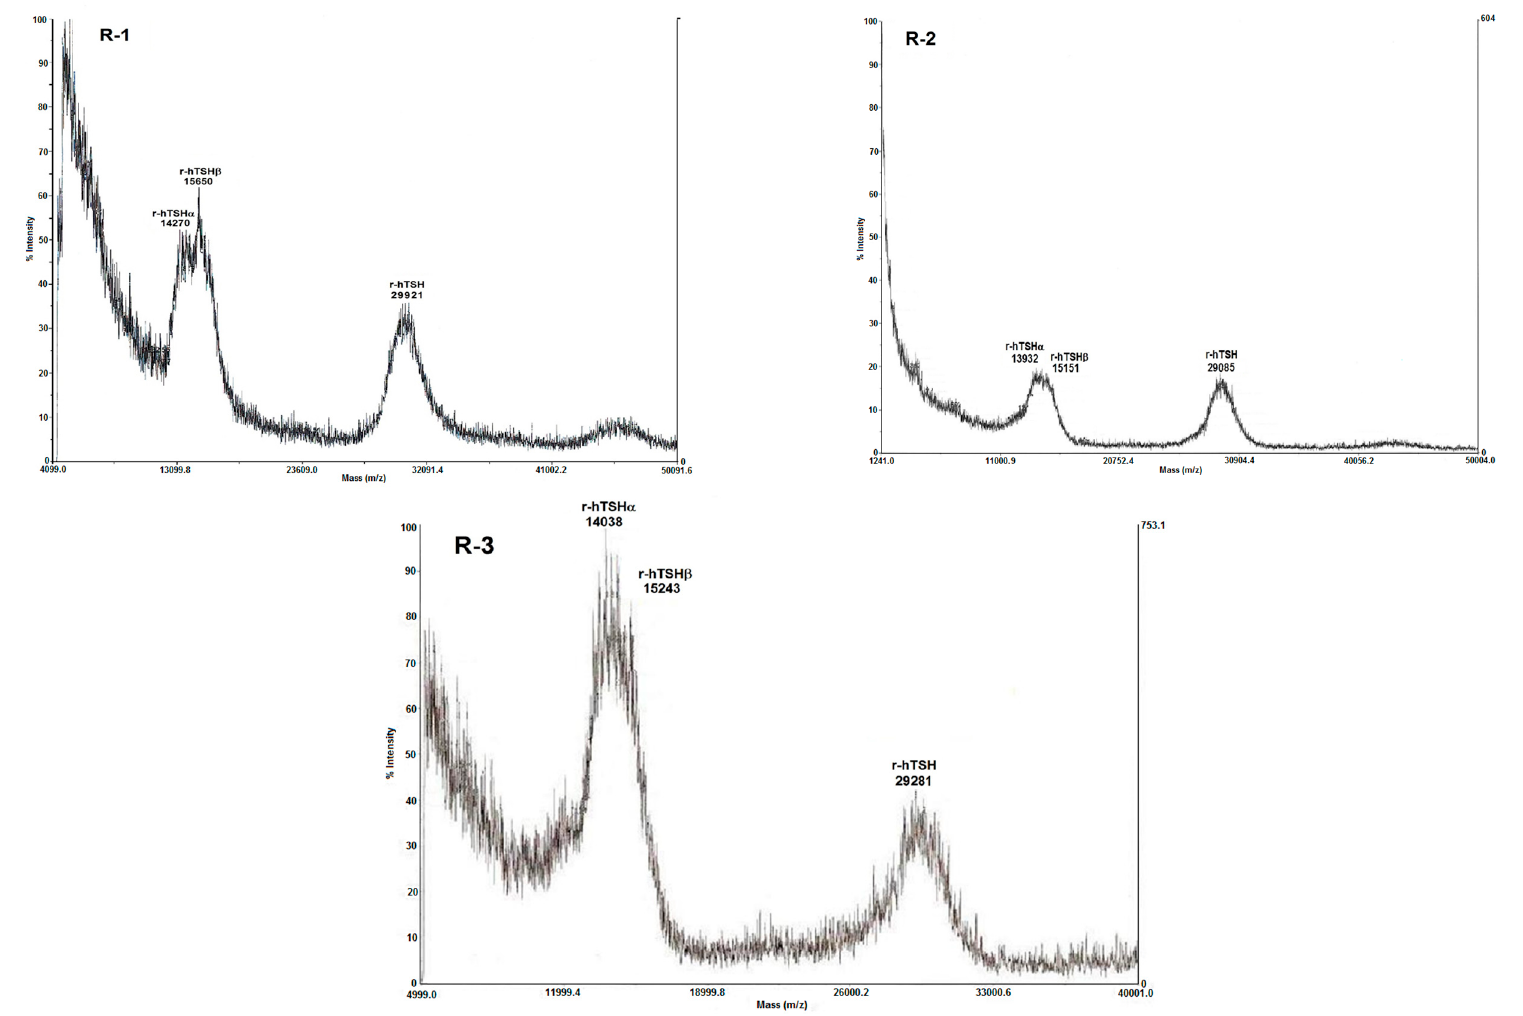
Figure 1. MALDI-TOF mass spectra of native, pituitary (P1, P2) and of recombinant (R1, R2, R3) hTSH preparations.